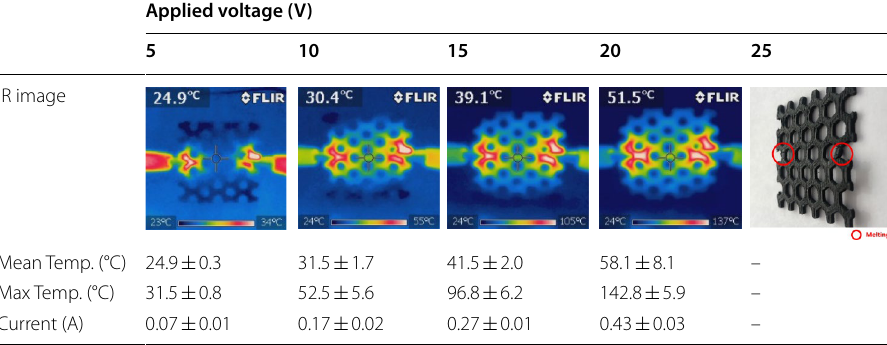
Table 11 IR images of MD graphene/PLA 3D printed honeycomb